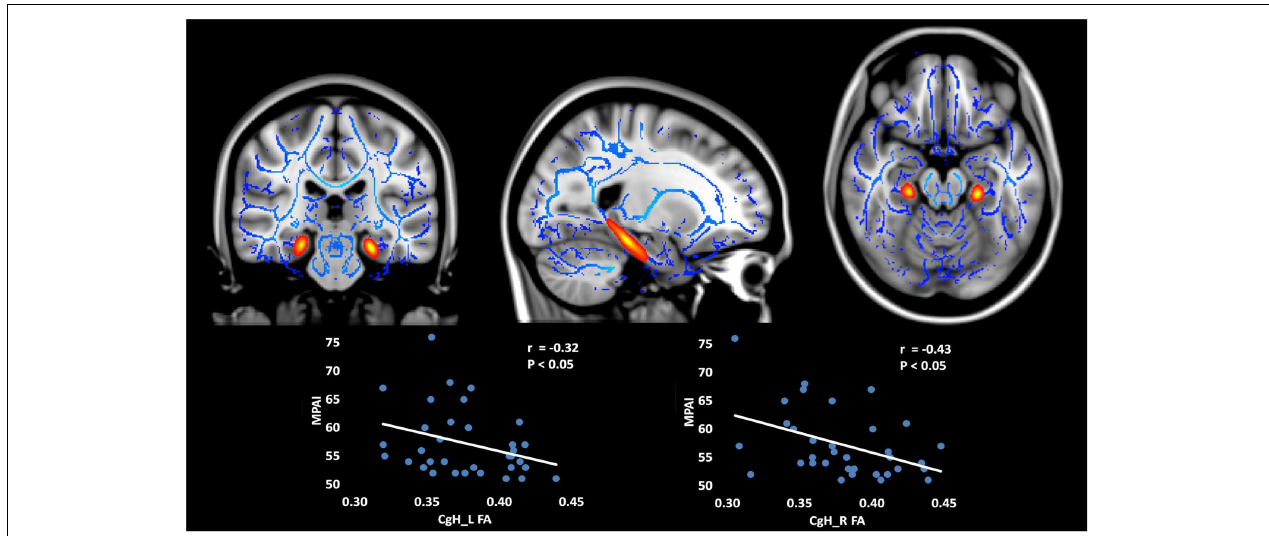
FIGURE 2 | Decreased FA and AD in bilateral CgH (subregions divided by Johns Hopkins stereotaxic atlases) in MPD group compared with control group (MPD < CG) and the negative correlation between FA and MPAI scores within MPD group. The FA and AD values of the CgH were significantly decreased in MPD individuals, relative to controls. Furthermore, within the MPD group, the FA of the CgH was negatively correlated with MPAI scores. CgH, cingulum bundle fibers in the hippocampus. FA, fractional anisotropy; AD, axial diffusivity; MPD, mobile phone dependency; CG, control group; MPAI, Mobile Phone Addiction